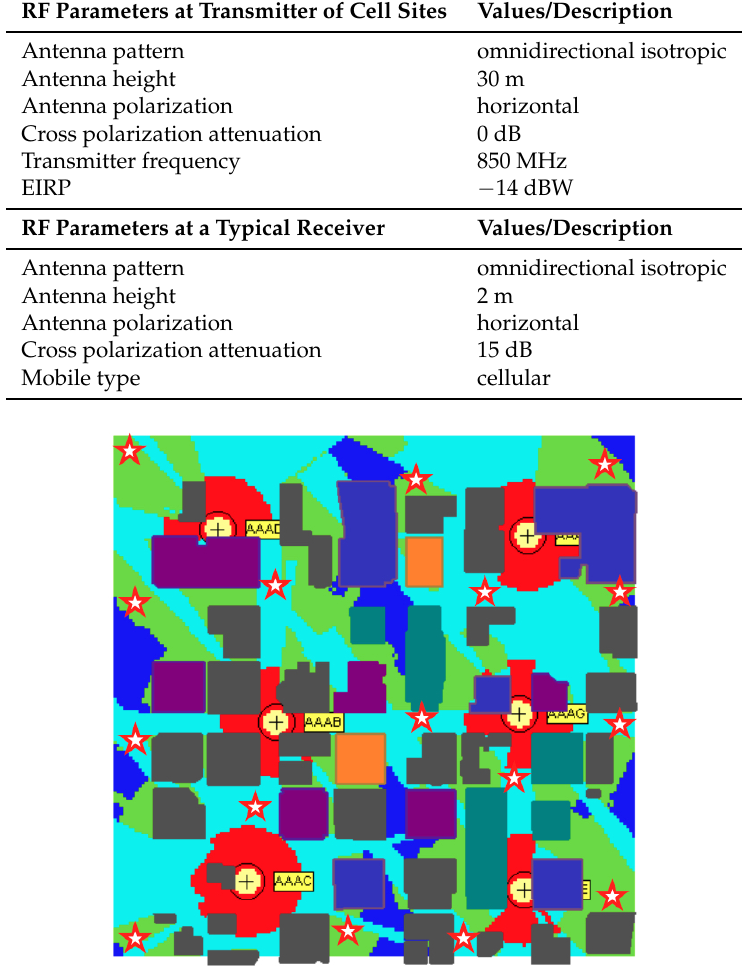
Figure 8. Wireless outdoor microcells with six candidate antenna positions and required coverage areas.